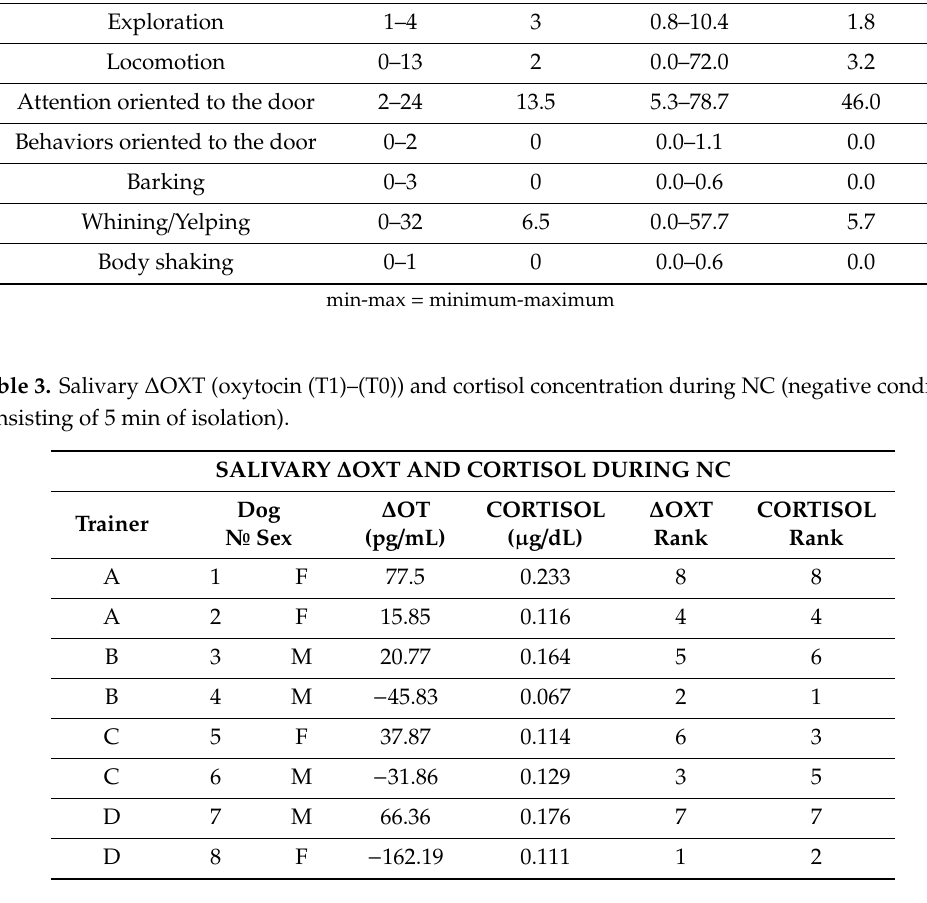
Table 2. Frequency and relative duration of presented behavior during 5 min of isolation.